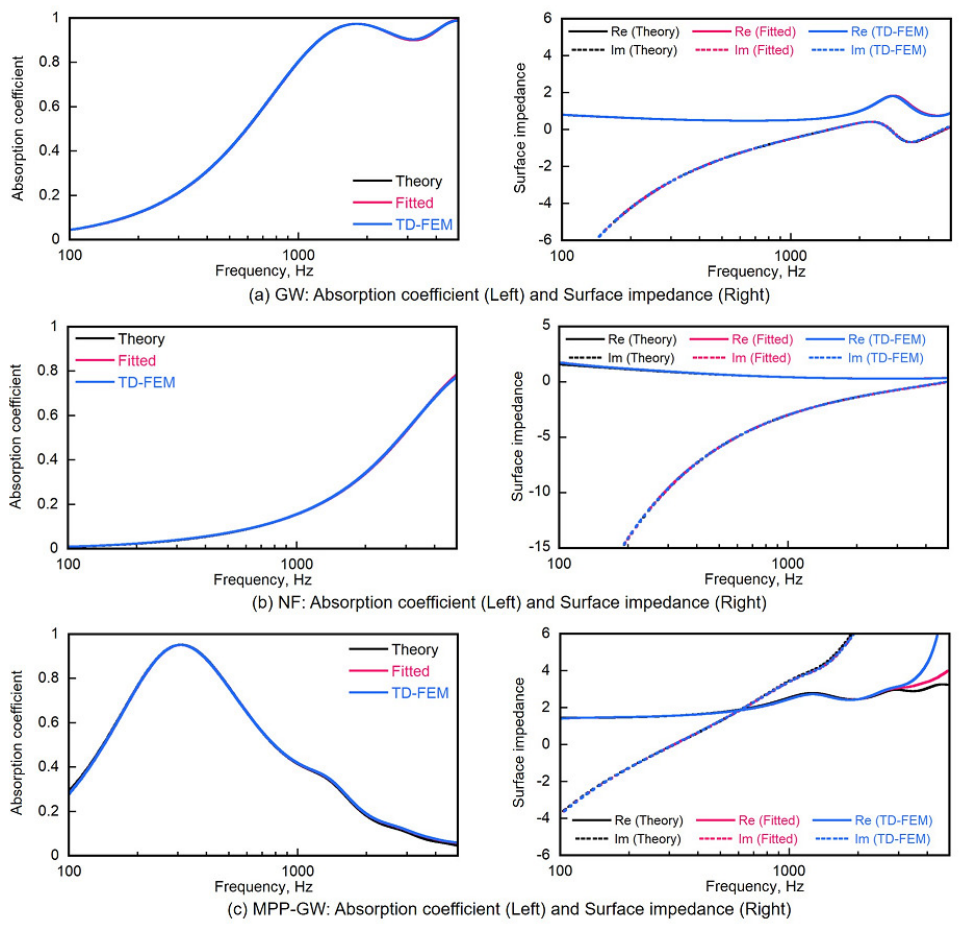
Figure 4. Comparisons of normal incidence absorption coefficient ( Left column ) and surface impedance ( Right column ) among the theory, the fitted rational model and the 4th-E TD-FEM for ( a ) GW, ( b ) NF, and ( c ) MPP-GW.